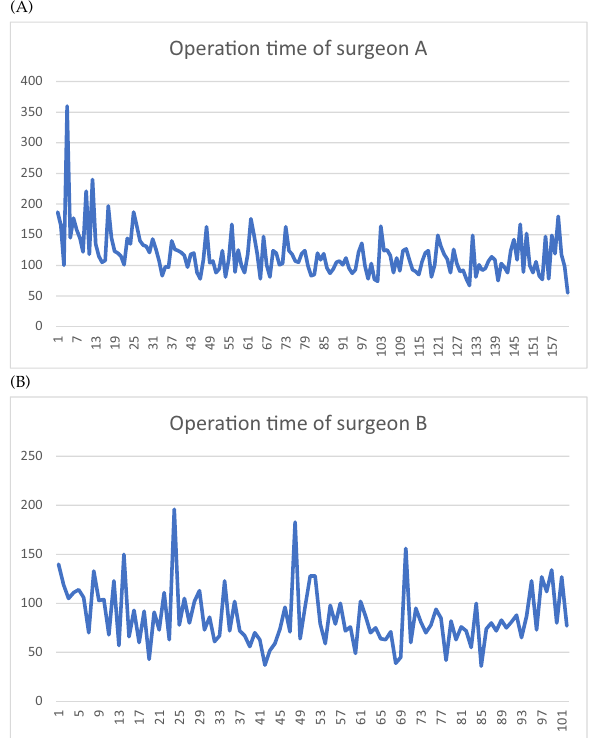
Figure 2. The operation time of pelvic reconstruction without or with mesh. Operation time were recorded. The x-axis indicates the number of procedures performed. The y-axis shows surgery time (minutes). (A) Vaginal pelvic reconstruction without mesh performed by surgeon A. (B) Vaginal pelvic reconstruction with mesh performed by surgeon